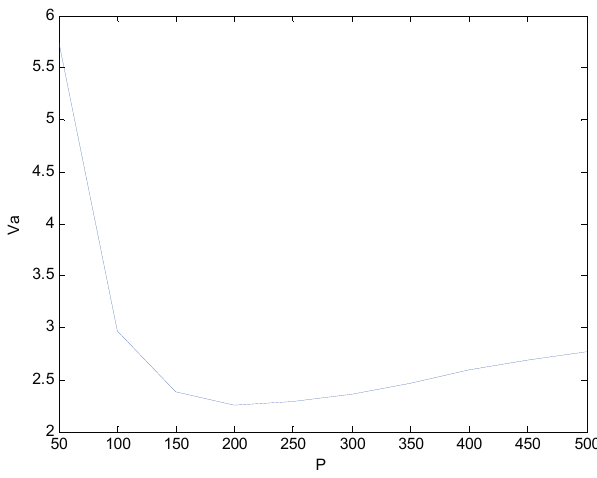
Figure A2. Relationship between P and Va